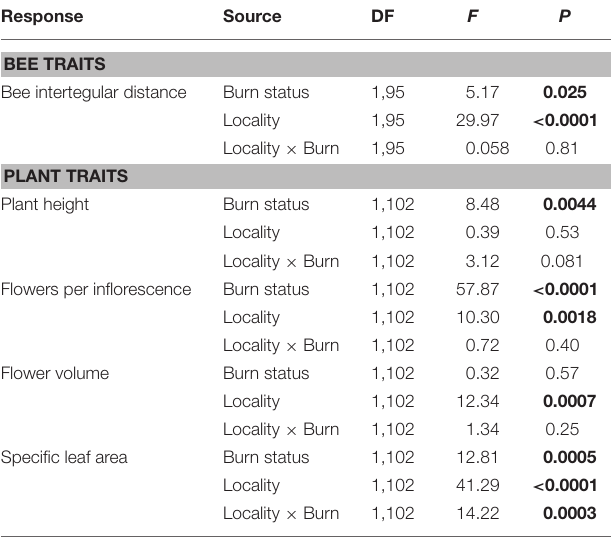
P-values < 0.05 are in boldface.